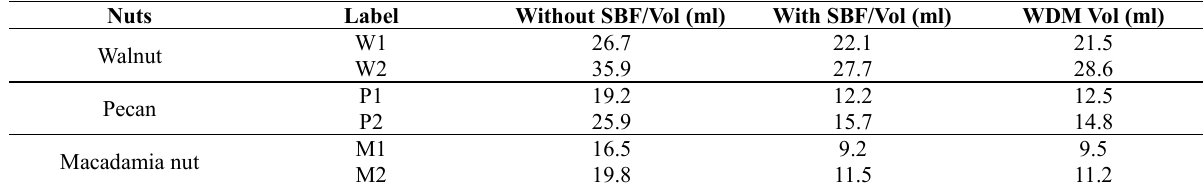
Figure 11. Best fit ellipsoid to the pecan point cloud: denoised nut point cloud (Red), edge noise (Blue), and the best fit ellipsoid model (Green). Table 1. Comparison of the estimated volume of nuts with SBF algorithm and without SBF